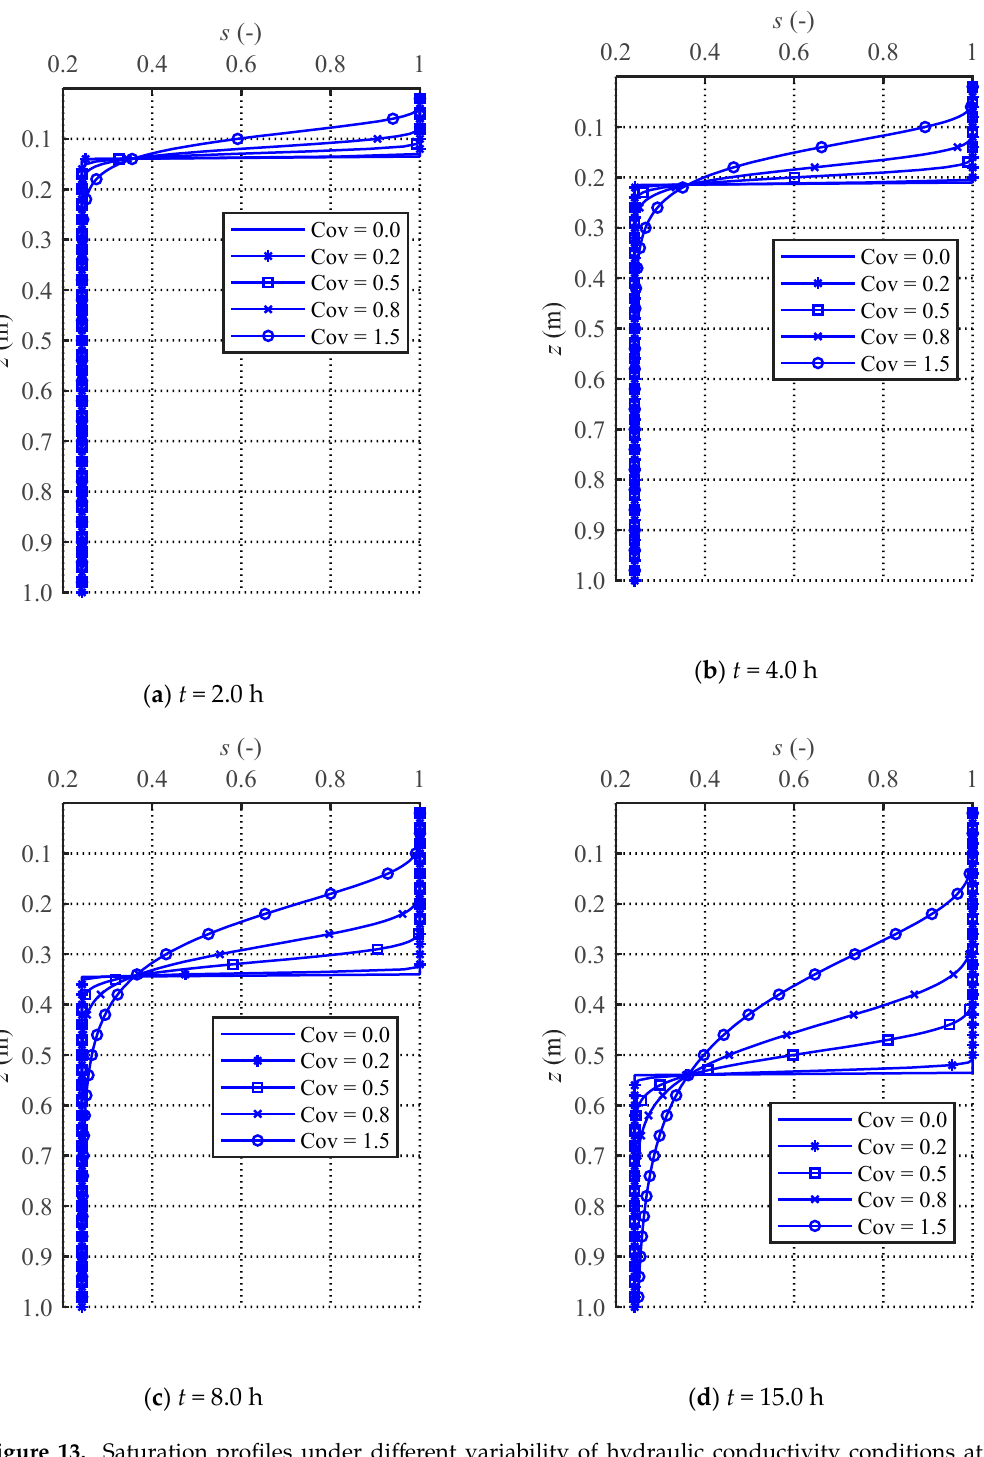
Figure 13. Saturation profiles under different variability of hydraulic conductivity conditions at different times.